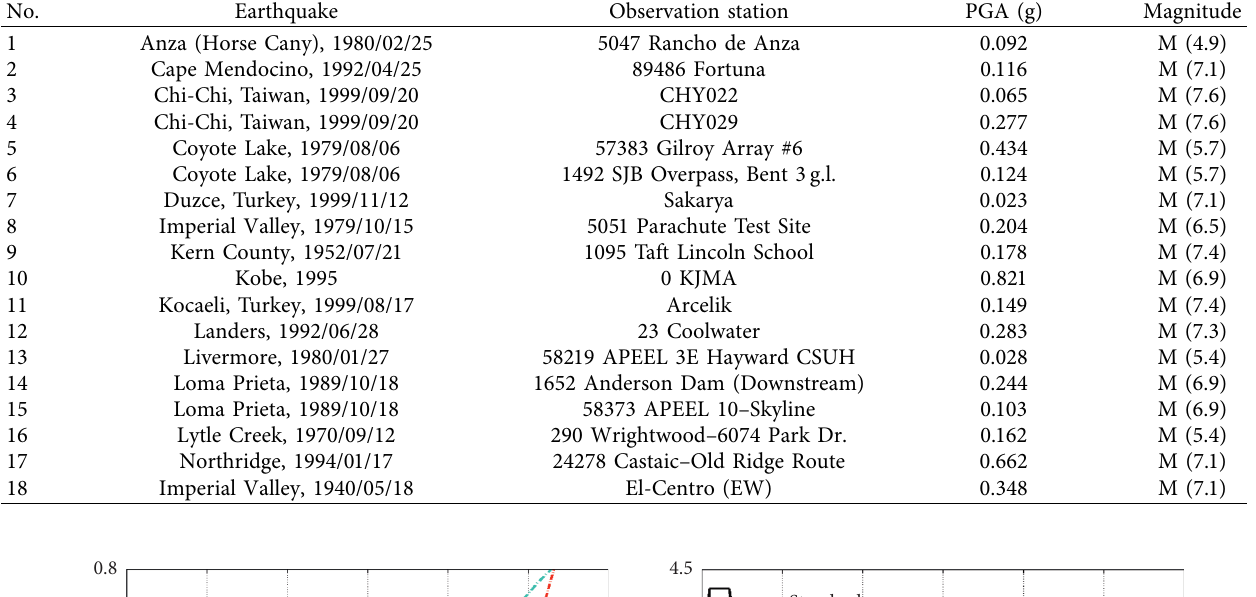
Table 1: Selected seismic waves.